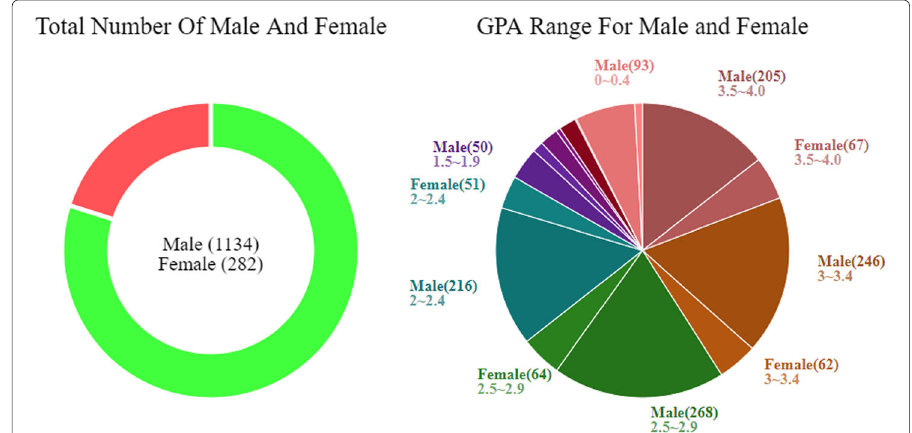
Fig. 8 Pie chart visualization of GPA analysis